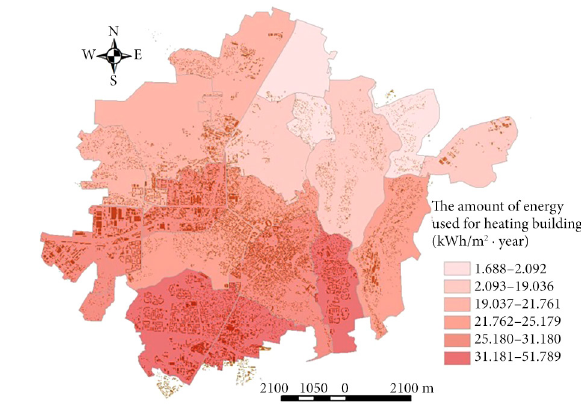
Figure 5. Geoinformation modeling of the urban environment by indicatirs of amount of energy used for heating buildings (kWh/m 2 per year)